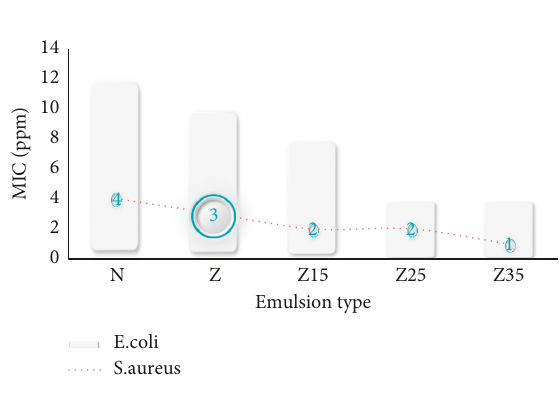
Figure 4: Bacteriostatic effect.